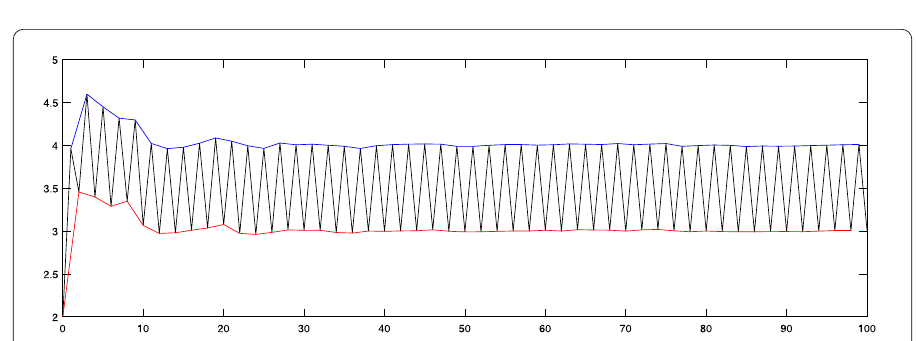
Figure 6 K = 2, a (0) = 1, a (1) = 1/2, ˆ g = 1. Sample trajectory, showing the dynamics of the solution (black line) and the two limits for s = 0 (red) and s = 1